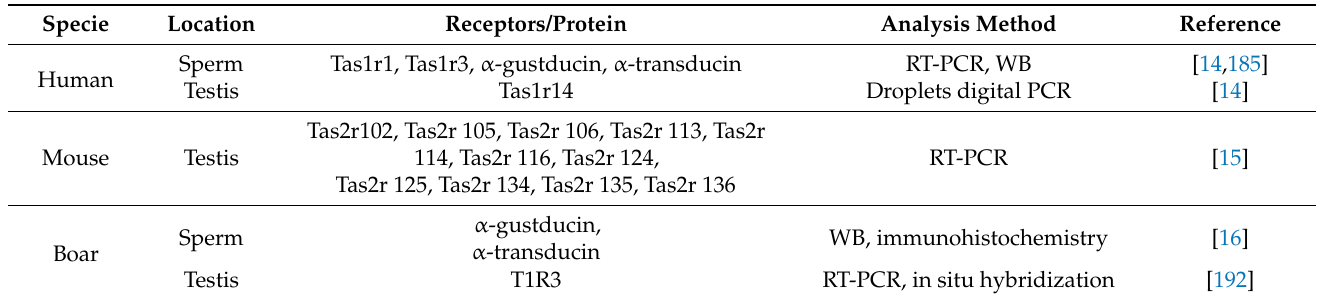
Table 4. Mammalian reproductive taste